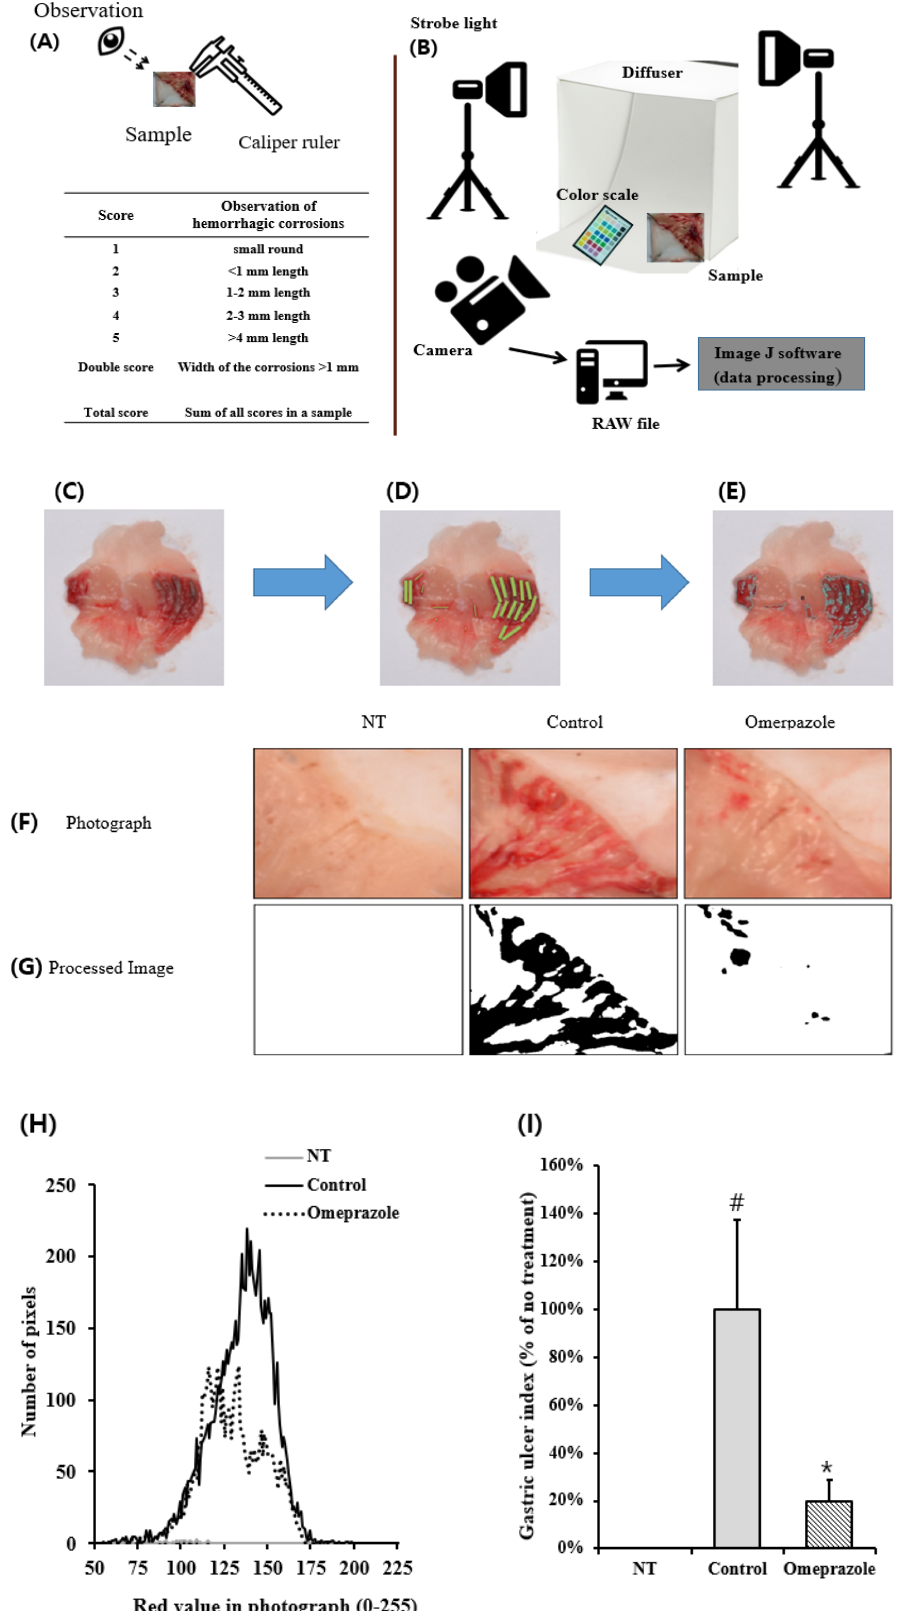
Figure 2. Application of ImageJ analysis on gastric ulcers by comparing the conventional clinical observation (CCO) method. ( A , B ) General description of CCO analysis ( A ) and ImageJ analysis ( B ) during determination of the gastric ulcer index. ( C – E ) Photographs of ethanol-induced gastric tissue ( C ) are shown to score the gastric ulcer index by CCO ( D ) or by ImageJ analysis ( E ). ( F ) Classical photographs of gastric organ in an ethanol-induced gastric ulcer model. In the model, the damaged zone was classified as slight or severe on the surface of the inner gastric organ by the ImageJ analysis